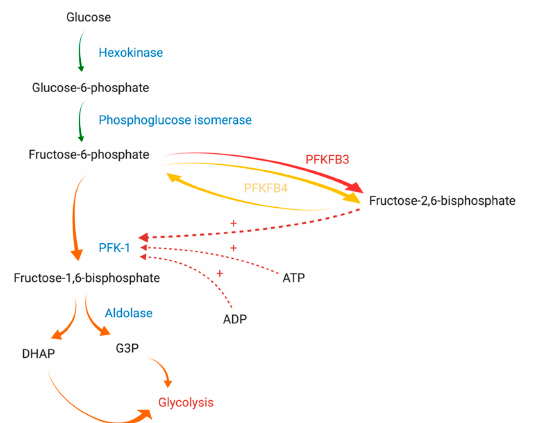
Figure 1. The graphical presentation of PFK-1 regulation by PFKFB3 and PFKFB4 adapted from Yi et al. (2019) and Clem et al. (2008) [11,12]. Diverse arrows colors are used to express the differences between reactions enhancement: (green) normal, (yellow) moderately enhanced, (orange) strongly enhanced, (red) extremely enhanced. Abbreviations: PFK-1 - phosphofructokinase-1; PFKFB3: 6- phosphofructo-2-kinase/fructose-2,6-bisphosphatase isozyme 3; PFKFB4: 6-phosphofructo-2-ki- nase/fructose-2,6-bisphosphatase isozyme 4; ATP: adenosine triphosphate, ADP: adenosine di- phosphate, DHAP: dihydroxyacetone phosphate; G3P: glyceraldehyde 3-phosphate. Created with BioRender.com. In humans, PFK-2/FBPase-2 is encoded by four different genes: PFKFB1, PFKFB2, PFKFB3, and PFKFB4 [13]. Thus far, four different PFK-2/FBPase-2 isozymes (PFKFB1, PFKFB2, PFKFB3, and PFKFB4) have been identified. Isozymes are characterized by tissue and functional specificity [14]. PFKFB1 can be found in the liver and skeletal muscle, PFKFB2 predominates in cardiac muscle, PFKFB3 is ubiquitously expressed, while PFKFB4 occurs mainly in testes [11]. The overexpression of two isozymes (PFKFB3 and PFKFB4) has been demonstrated in various solid tumors and hematological cancer cells [15–17]. Furthermore, due to slight differences in amino acid sequences at key sites for enzy- matic activity, all of the isozymes have a different affinity for the synthesis or degradation of F-2,6-BP. Their activity is expressed as the kinase/phosphatase ratio (also termed the 2- Kase/2-Pase activity ratio) [11]. This ratio is about 4.6/1 for PFKFB4 and 730/1 for PFKFB3, while it does not exceed 2.5/1 for PFKFB1 and PFKFB2. Isoforms commonly expressed in tumors satisfy increased energetic requirements of neoplastic cells more efficaciously. Thus, glycolysis, the hallmark of malignancy, might be vulnerable to the therapy affecting only isoforms characterized by a high kinase/phosphatase ratio [10,18]. 2. PFKFB Genes and Proteins The four genes encoding the different isozymes of PFK-2/FBPase-2 are located on distinct chromosomes, i.e., PFKFB1—Xp11.21, PFKFB2—1q31, PFKFB3—10p14-p15, and PFKFB4—3p21-p22 [19]. Despite the fact that the core sequences of all four genes exhibit high homology and similarities in the genomic organization, PFK-2/FBPase-2 isozymes display diverse catalytic properties (kinase/phosphatase ratio). The level of bifunctional- ity is determined by the unique structure of PFK-2/FBPase-2. The molecular weight of